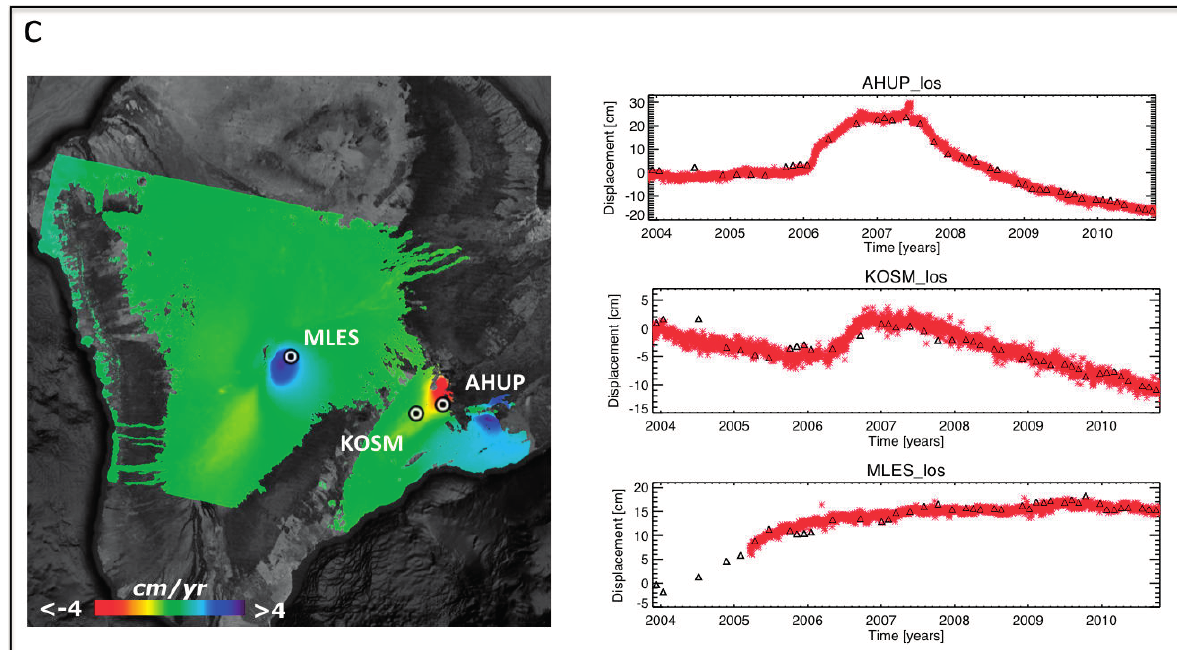
Figure 4. Unsupervised P-SBAS processing chain validation experiments. Per each of the three selected test sites are shown: the mean deformation velocity maps retrieved from the P-SBAS analysis; the locations of three selected GPS stations; the comparison between the GPS (red stars) and the P-SBAS (black triangles) surface deformation time series relevant to the stations identified in the corresponding map; the standard deviations ( σ ) of the difference between the GPS and the DInSAR measurements. ( a ) Campi Flegrei caldera. ( b ) Los Angeles. ( c )